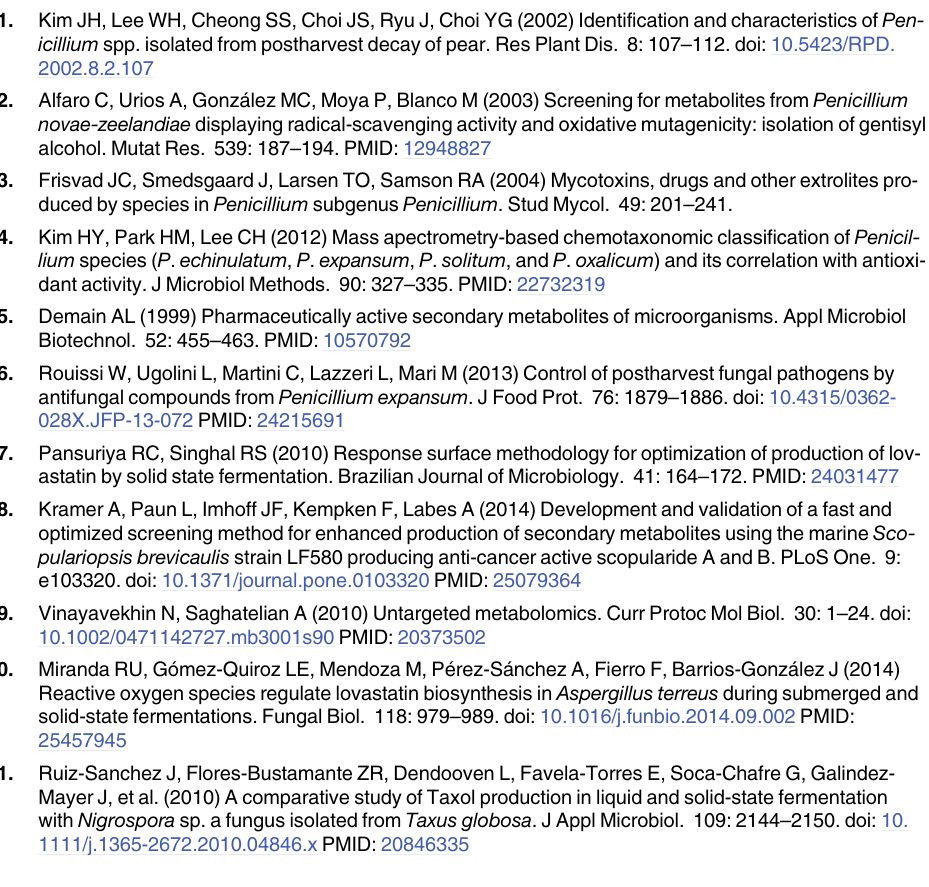
SSF/SmF abundance 2